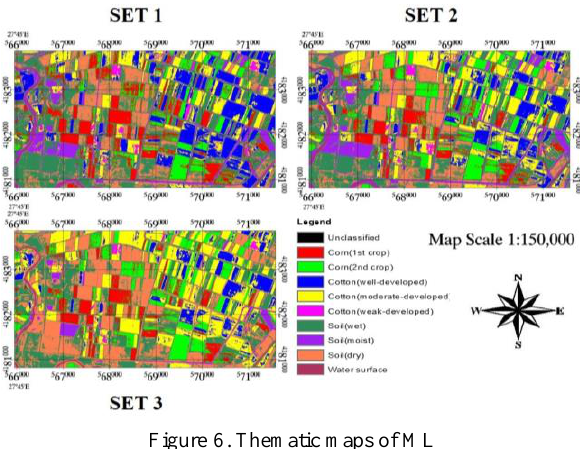
Figure 6. Thematic maps of ML